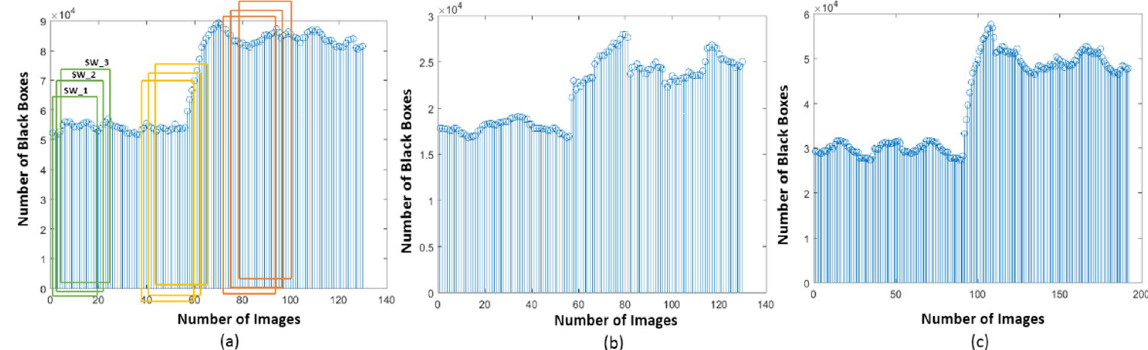
Figure 1. Box-count distribution of PSR images, case ( a – c ) corresponds to QT interval, PR interval and QRS complex respectively. * SW: Sliding Window (Box-count values of 20 PSR images), Green Window: Healthy QT interval, Yellow window: Healthy + Unhealthy QT interval, Orange: Unhealthy QT